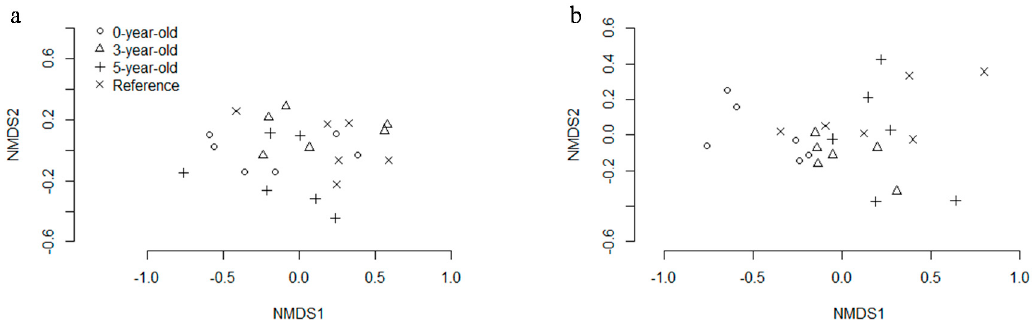
Figure 3. The NMDS ordination plot showing the species seed dispersal trait composition in the ( a ) upland and ( b ) lowland areas. The NMDS was based on the Bray–Curtis similarity index computed using species abundance data.